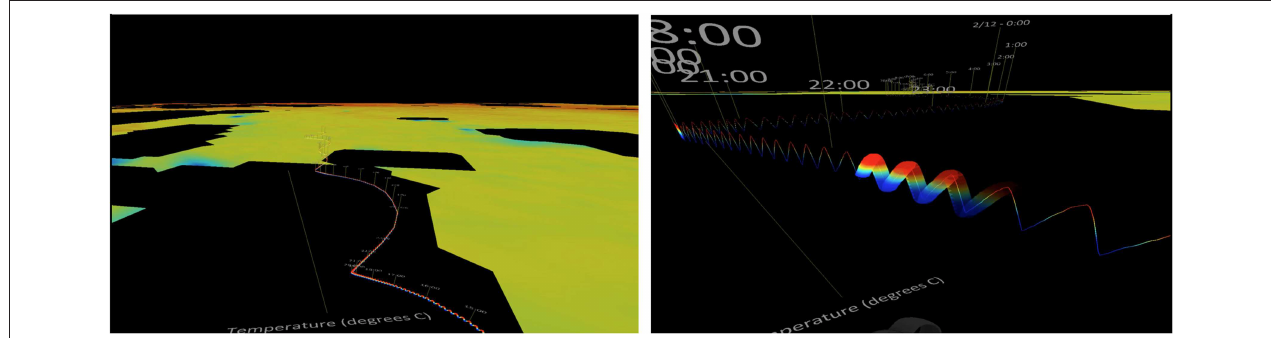
FIGURE 3 | A VR user’s view inside the autonomous vehicle data visualization application. Left : Satellite ocean color data (NASA Ocean Biology Processing Group, 2015) is combined with Wirewalker drift tracks and in situ sensors. This bird’s eye view of data shows a three day deployment in the North Pacific. Right : Successive, high resolution profiles of the top 120 m of the water column are combined to create animations of the vehicle’s 3D position throughout the course of the vehicle deployment. Each real world vertical profile (10–20 min per profile) is replayed in VR at 2 s per profile. Users can toggle between CTD variables, fly through the scene, and change the spatial scaling in the vertical dimension with the Oculus Touch